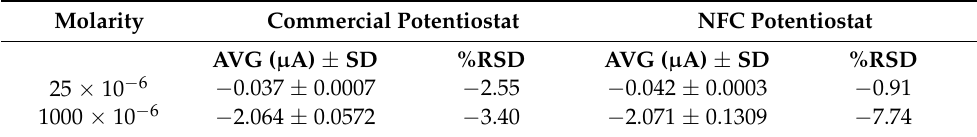
Figure 6. ( a ) The chronoamperometry recorded in 25–100 µM ferricyanide solution measured by the NFC potentiostat (red) and the commercial potentiostat (black). ( b ) The linear correlation between current and concentration of ferricyanide. Table 2. The average (AVG), standard deviation (SD) and relative standard deviation (RSD) value of the current obtained from both potentiostats in chronoamperometric measurements.